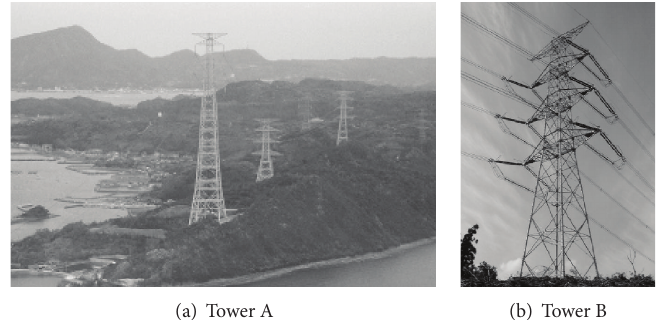
Figure 10: Elevation of the example towers.